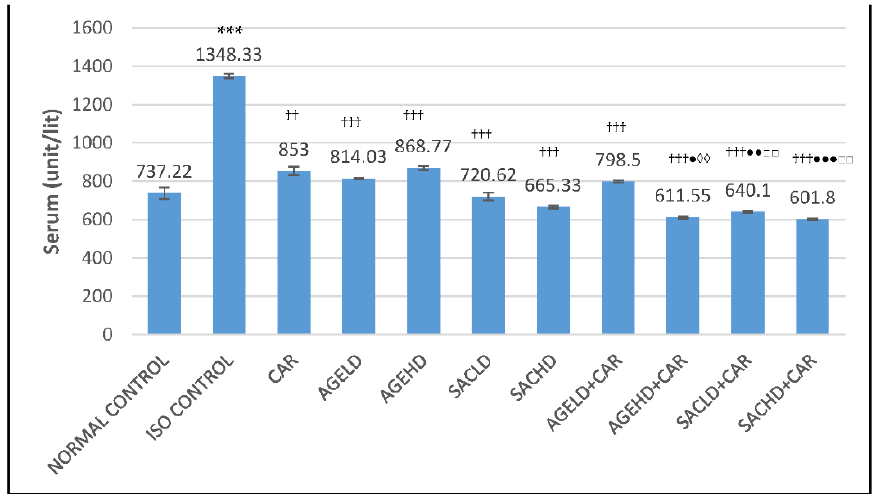
Figure 2. Effect on serum LDH activities. The data are given as mean ± SEM; *** p < 0.001 compared with normal control; †† p < 0.01, ††† p < 0.001 in comparison with ISO control; ● p < 0.05, ●● p < 0.01, ●●● p < 0.001 in comparison with carvedilol; ◊◊ p < 0.01,when compared with respective AGE dose; □□ p < 0.01 when compared with respective SAC dose; ISO (isoproterenol, 150 mg/kg); CAR (carvedilol 10 mg/kg); AGELD (aged garlic extract low dose 2 mL/kg); AGEHD (aged garlic extract high dose 5 mL/kg); SACLD (S ‐ allyl cysteine low dose 13.1 mg/kg); SACHD (S ‐ allyl cysteine high dose 32.76 mg/kg).